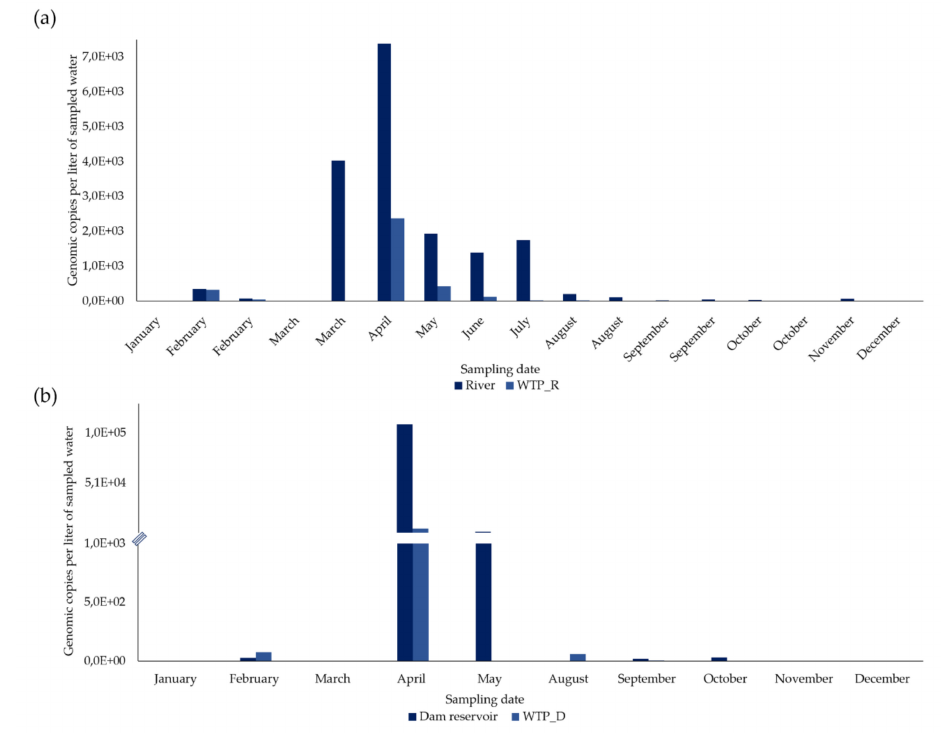
Figure 2. Variation in the concentration of hepatitis E virus (HEV) RNA detected in concentrated water sampled in four sampling sites during 2019. ( a ) River and WTP_R ( n = 34). ( b ) Dam reservoir and WTP_D ( n = 20). RT-qPCR results (average values from two independent reactions), in gc / L, indicate estimated genomic copies per liter of sampled water (based on data from Table